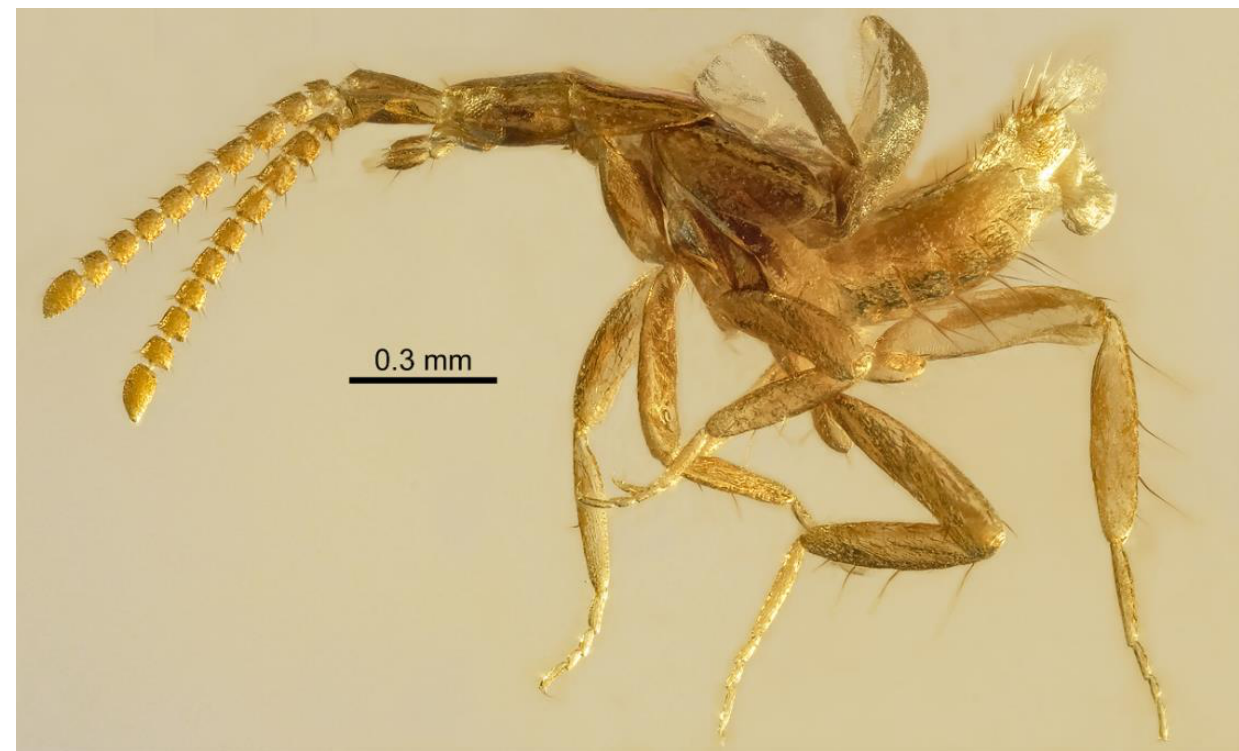
Figure 1. Pareburniola dominicana gen. et sp. nov. Habitus, in lateral view. Photo credit: A, P. Gouveia.